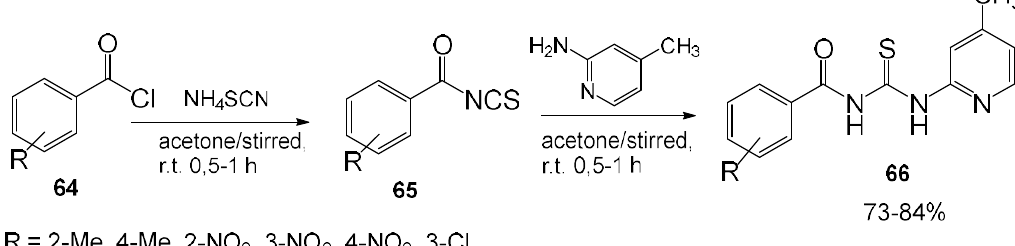
Fig. 19. Approaches to the synthesis of substituted thioureas with aroyl and heteroaryl fragments